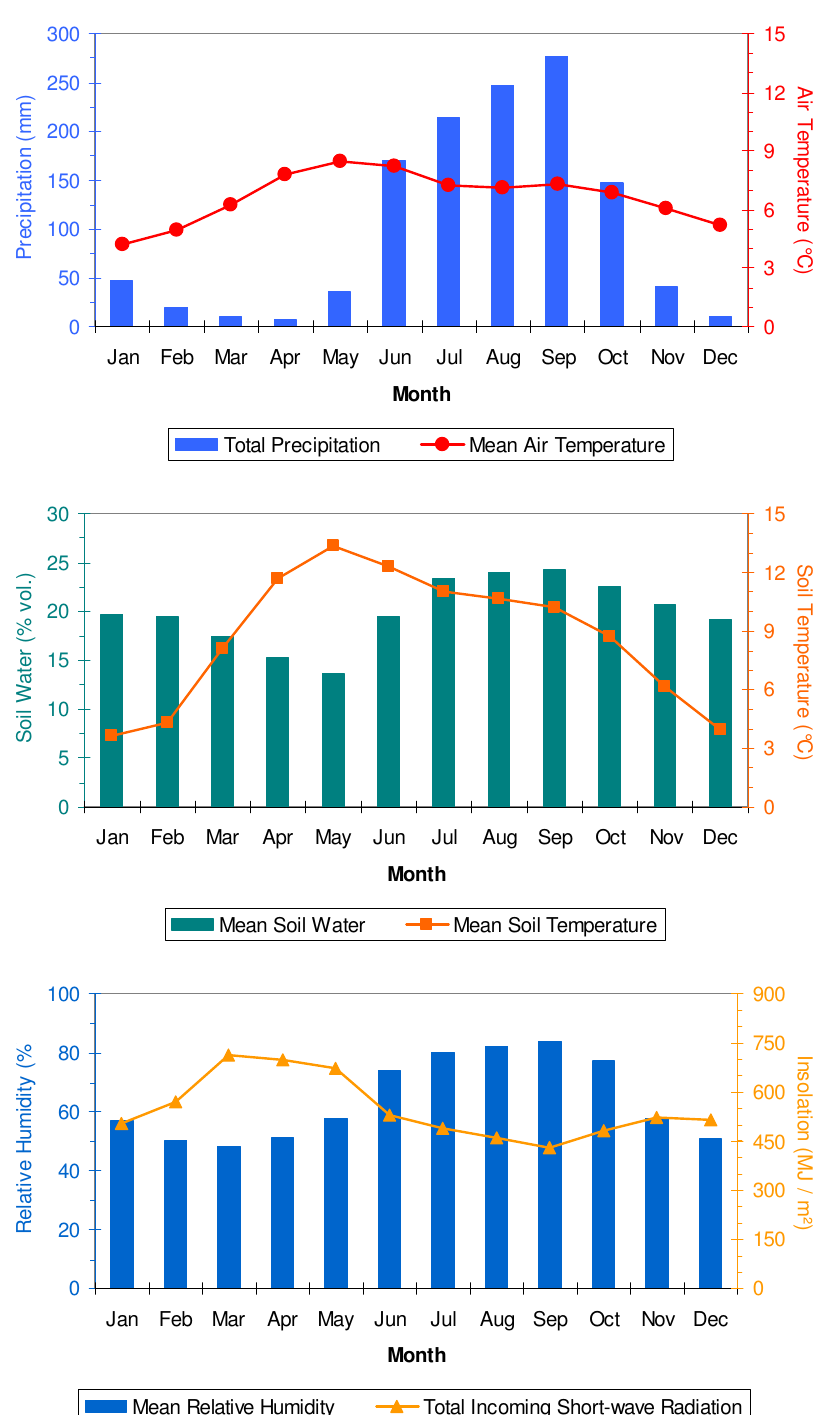
Figure 2. Climatic diagrams showing average monthly variables based on 2002–2008 data from the automated weather station. Soil data were collected at about 30 cm below ground, precipitation at about 1 m above ground, air temperature and relative humidity at about 2 m above ground, and total insolation at about 3 m above